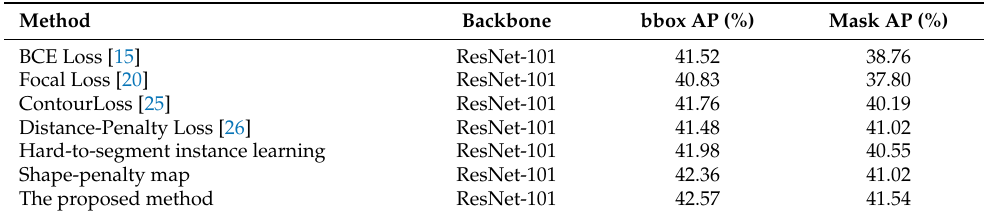
Table 1. Instance segmentation comparison of BCE Loss, Focal Loss, ContourLoss, Distance-Penalty Loss and the proposed method on the iSAID-Reduce100 val